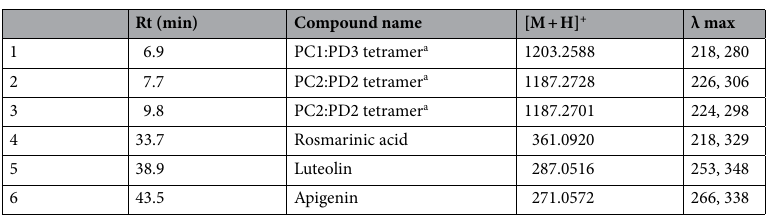
Table 1. Retention time (R t ), compound name, experimental mass number [M + H] + , and ultraviolet absorption maxima (λ max ) of peaks. a PC and PD are abbreviations for procyanidin and prodelphinidin.